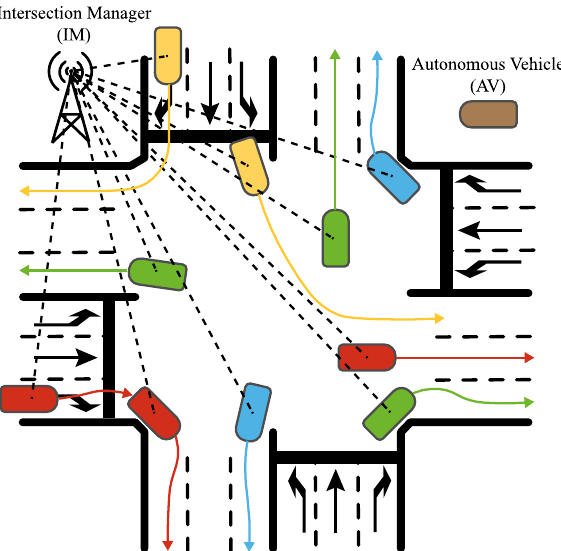
Figure 1. Example of Autonomous Intersection Management (AIM). The Intersection Manager (IM) communicates with the Autonomous Vehicles (AVs) through a wireless communication network and guides them on the action to be taken by each AV. The AIM operates within the